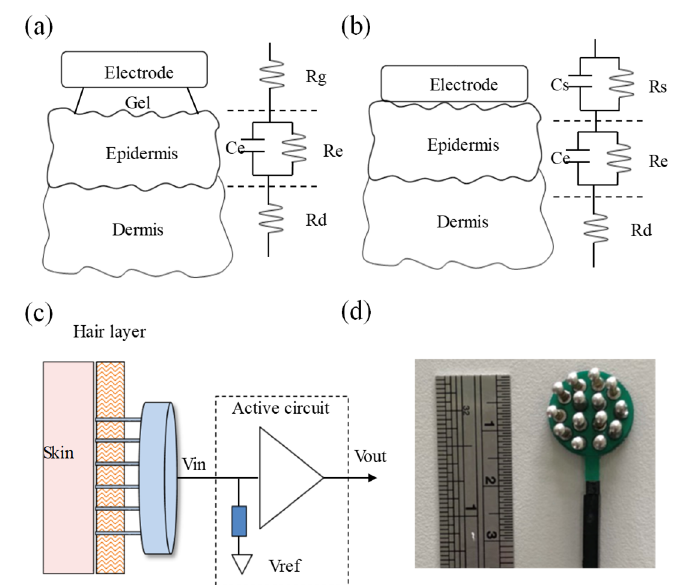
Figure 2. Skin–electrode interface models of ( a ) electroencephalography (EEG) electrode with conductive gels and ( b ) dry electrode. ( c ) Basic scheme and ( d ) photograph of active dry electrode.